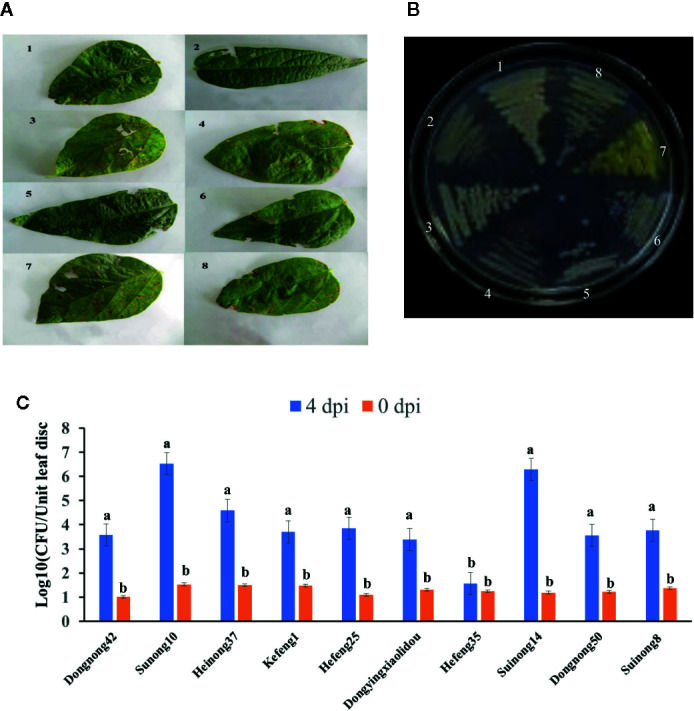
Isolation and pathogenicity analysis of XvNEAU001WT. (A) BLP leafs isolated for the soybean field. (B) candidate bacterial pathogen cones isolated from the leaf. (C) Phenotype analysis of soybean germplasm after 4 days inoculated with XvNEAU001WT. Leaves 1–6 were isolated from the soybean field of Harbin, Leaves 7 and 8 were isolated from the soybean field of Jiamusi. The bar and error bars is the mean and standard deviation. Bars with different letters are significantly different at p <0.05 as analyzed by Duncan’s multiple comparison test. The circle marked region was isolated sed to perform RNA-sequencing. The days to measurement of the bacterial growth were four days after inoculation. Three trifoliate were used to calculate the number. The biological analysis on soybean germplasm was conducted for three times.